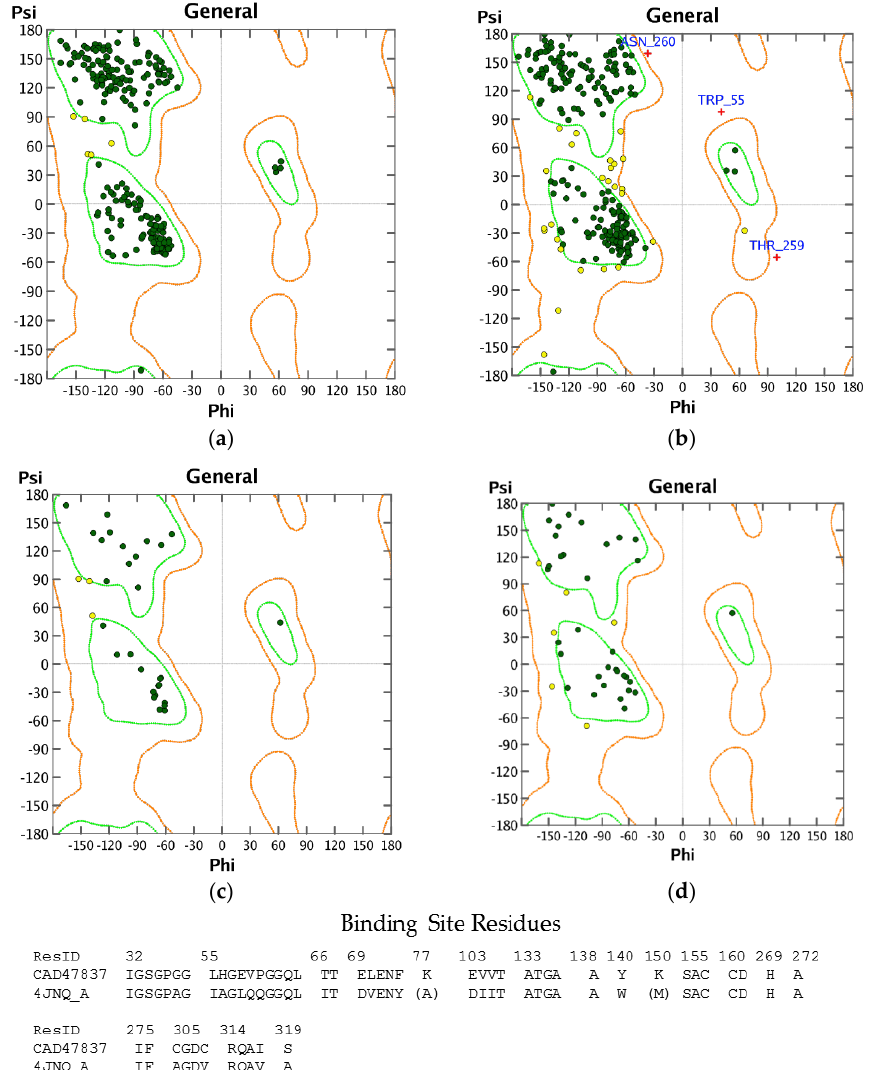
Figure 1. Ramachandran plots of thioredoxin reductase (TrxR) protein structures: ( a ) Brucella melitensis TrxR (PDB 4JNQ [24]); ( b ) homology model of Trichomonas vaginalis TrxR; ( c ) binding site of BmTrxR; ( d ) binding site of TvTrxR ( T. vaginalis thioredoxin reductase). ResID: amino acid residue identification.